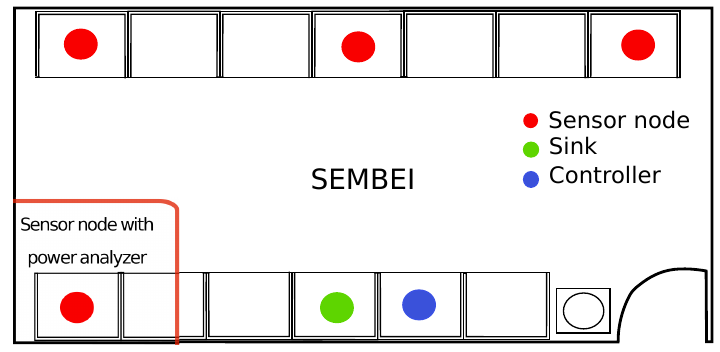
Figure 2. Network deployed for energy consumption